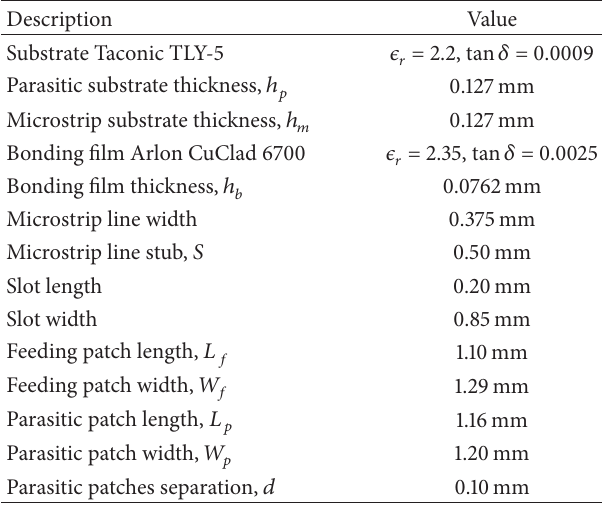
Table 1: Stacked microstrip antenna design parameters.